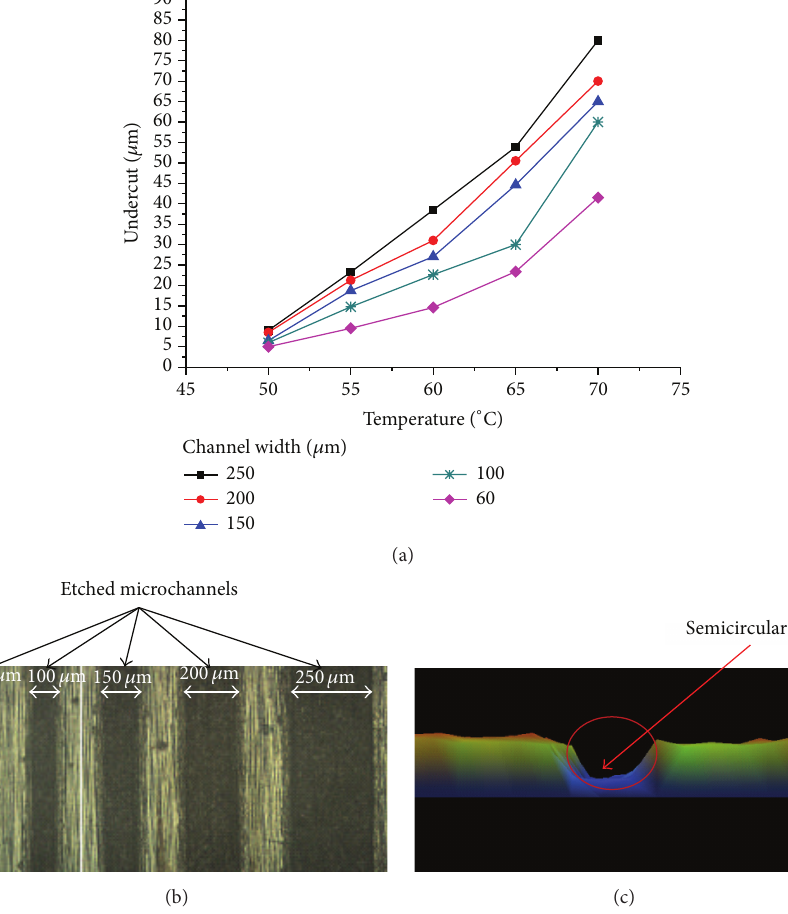
Figure 8: (a) Effect of temperature on undercut for different channel widths. (b) Nikon microscope image of etched channels. Temperature: 55 ∘ C; etching time: 6 min; and concentration: 600 g/L. (c) Semicircular shape of microchannel (white light interferometry image).